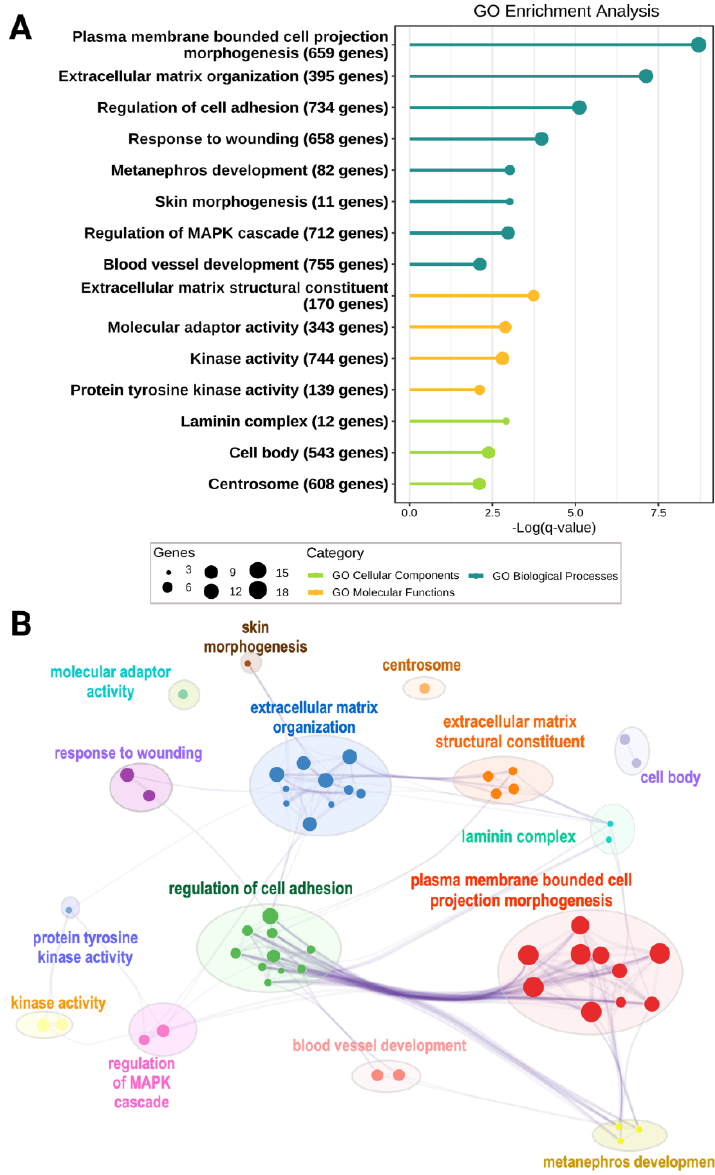
Figure 2. Gene ontology (GO) enrichment of rare de novo, biallelic, and digenic genotypes in L-HSCR patients (Data from Tang et al. [75]). ( A ) Top GO terms enriched in genes ( n = 77) with rare de novo or biallelic genotypes identified from L-HSCR patients’ functional analysis of variants ( q -value < 0.01). Among the 77 genes, 58 genes have either de novo or biallelic variants, and 19 genes encode interacting partners to any of these 58 candidate genes. ( B ) Interaction network of GO enriched terms grouped by functional relevance using Metascape. Top GO cluster of plasma membrane bounded cell projection morphogenesis represents GO terms related to cell morphogenesis involved in neuron differentiation, neuron projection guidance and axon guidance. Other closely interacted GO clusters included regulation of cell adhesion, ECM organization, and structural constitute, as well as laminin complex. Each node represents a GO term, and only GO terms with q -value < 0.01 are shown.